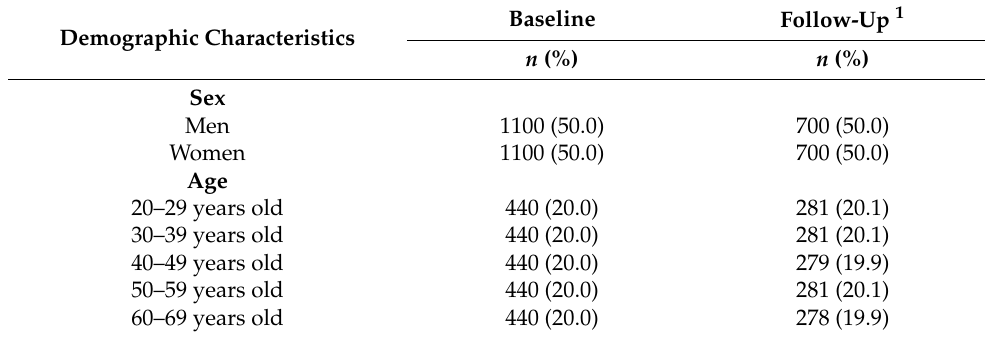
Table 1. Demographic characteristics of employees who participated in the present study. Demographic